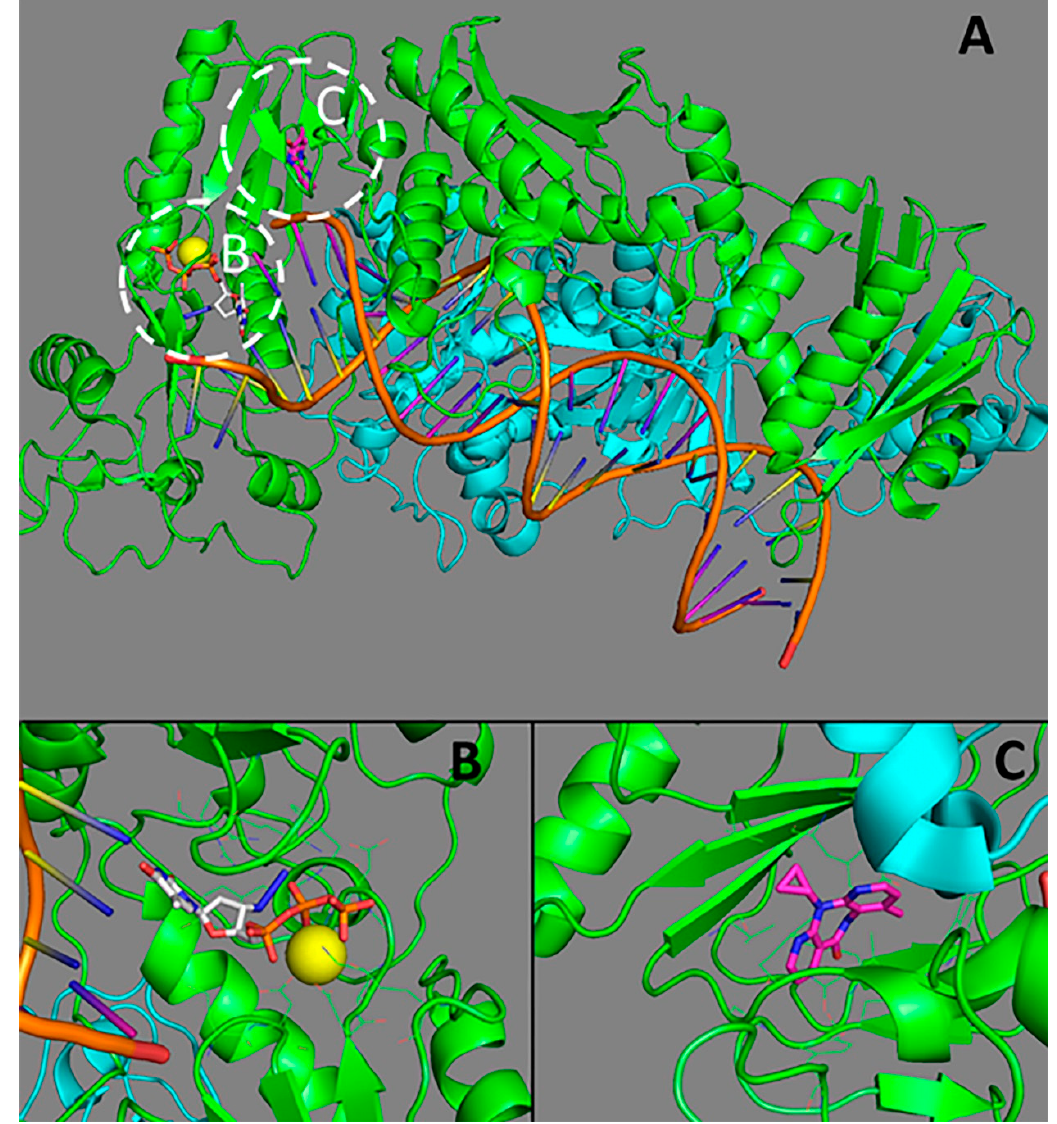
Figure 1. The structure of HIV-1 reverse transcriptase (RT). ( A ) an overall representation of RT; ( B ) the active site of RT (binding site of nucleoside reverse transcriptase inhibitors (NRTI)); ( C ) the allosteric site (binding site of non-nucleoside reverse transcriptase inhibitor (NNRTI)). p66 subunit is represented in green, p51 subunit is given cyan; Mg 2+ is in yellow; zidovidine is white; nevirapine is magenta. The structures from the Protein Data Bank [27] PDB ID 3V4I [28] and 4PUO [29] were used.